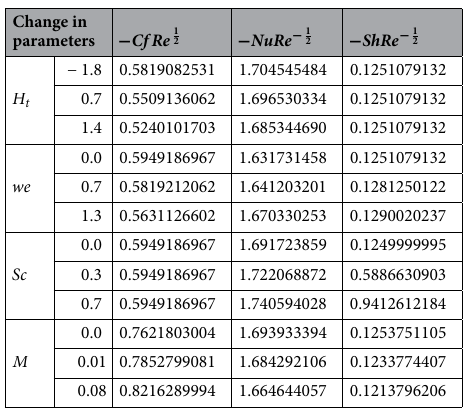
Table 4. Numerical consequences of mass diffusion rate, divergent velocity and heat energy rate versus impacts of heat source, Weissenberg, Schmidt and magnetic parameters when α = 0.5, m = 0.3, Re = 4.0, Pr = 206, δ 1 = 0.4, ph 1 = 0.003, ϕ 1 = 0.003, ϕ 2 = 0.004, ϕ 3 =